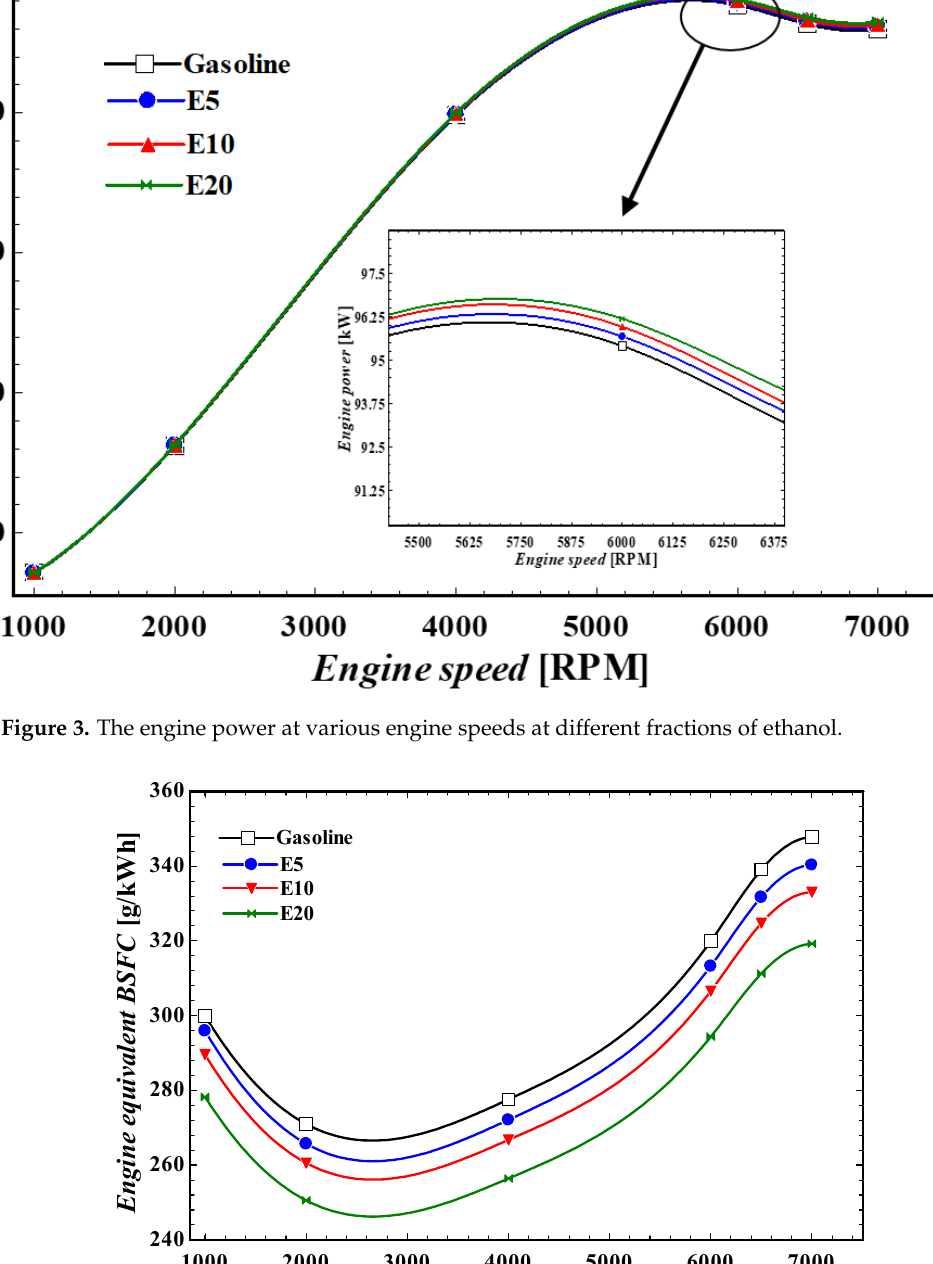
Figure 4. Engine equivalent BSFC at various engine speeds at different fractions of ethanol.